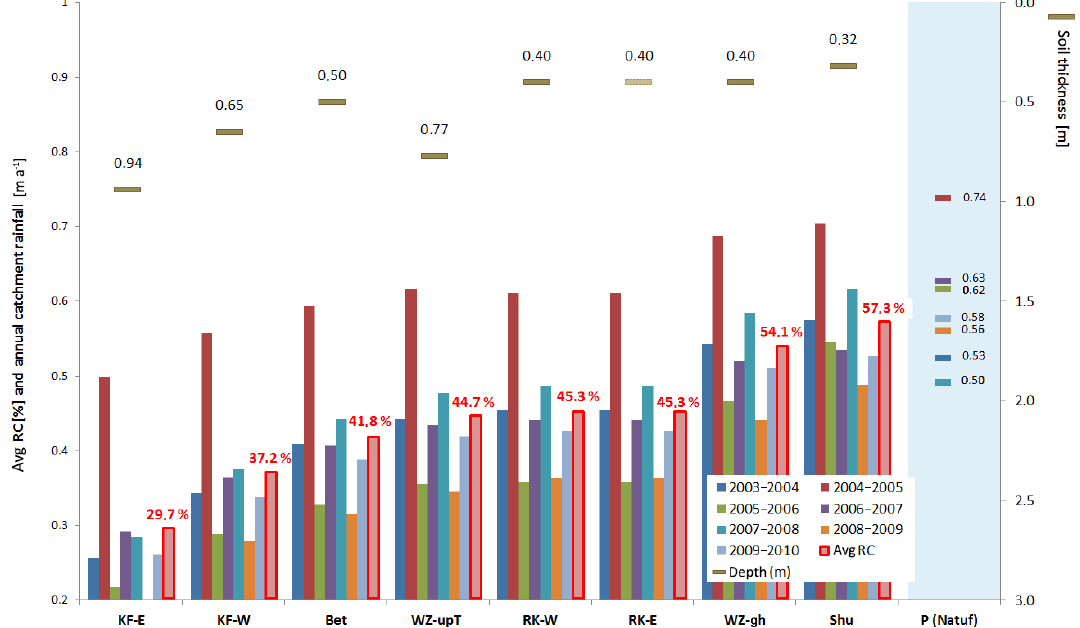
Figure 8. Annual recharge coefficients, annual precipitation and soil depth (stations ordered by increasing RC). The coloured lines present annual recharge coefficients by station ( x axis), increasing from left to right (as a percentage). Average annual RC values (red numbers) are reciprocal to the respective soil depths (as brown bars, with the exception of WZ-upT as a beige bar). The blue-shaded column at the right indicates annual precipitation – shown as P (Natuf) – as the area average (in ma − 1